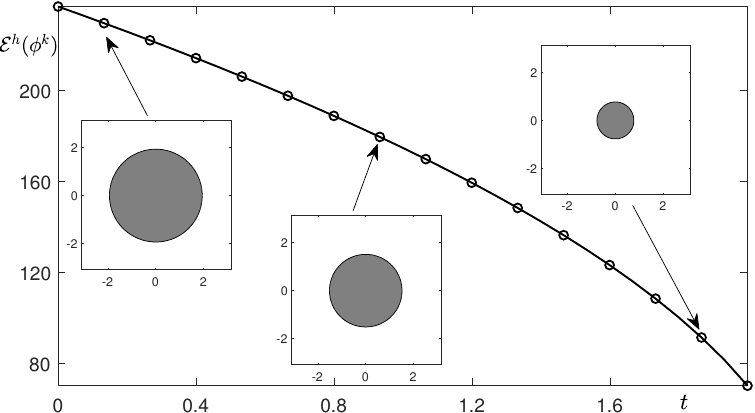
Figure 7. ( a , b ) are the zero-level contours over time with the initial conditions Equations (34) and (35) , respectively.